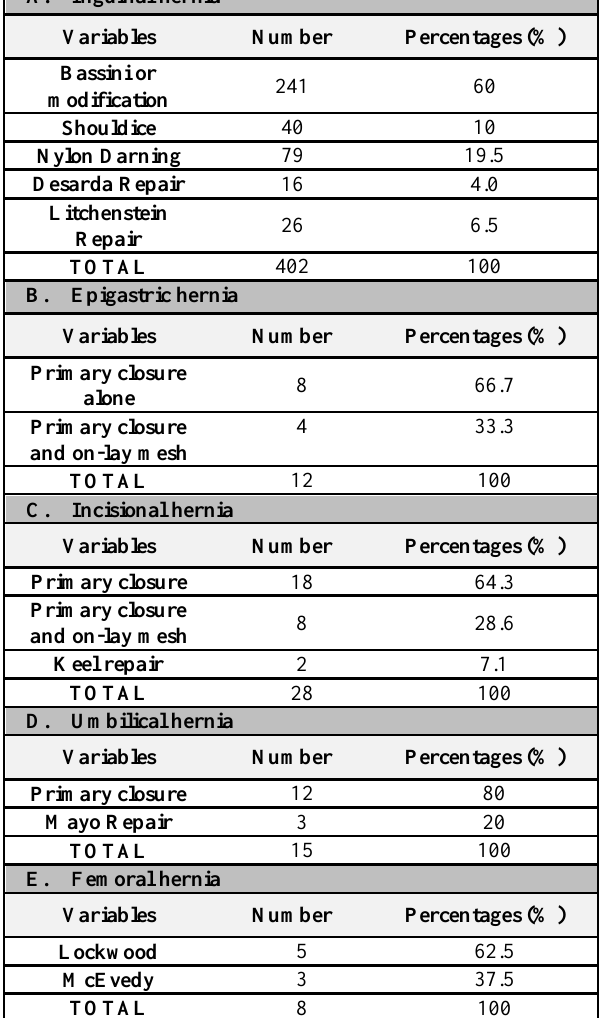
Table 3. The various surgical procedures